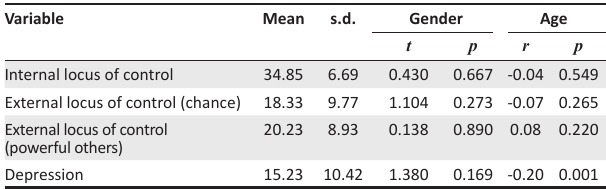
TABLE 1: Average locus of control and depression scores by gender and